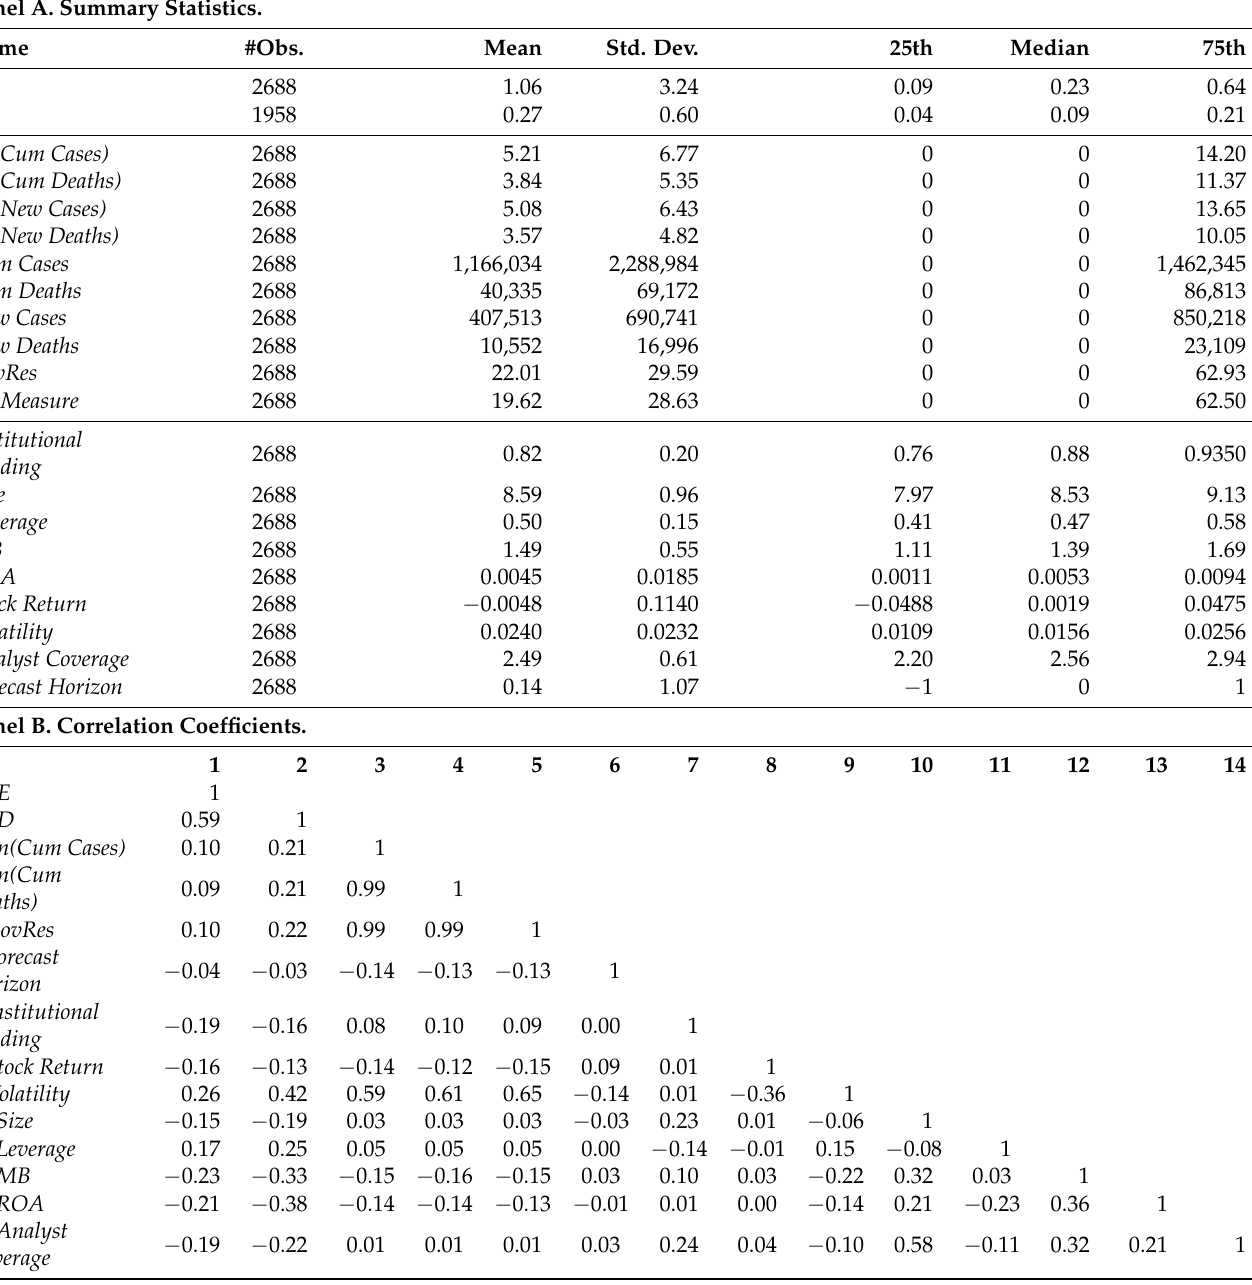
Table 2. Summary Statistics and Correlation Coefficients. Panel A. Summary